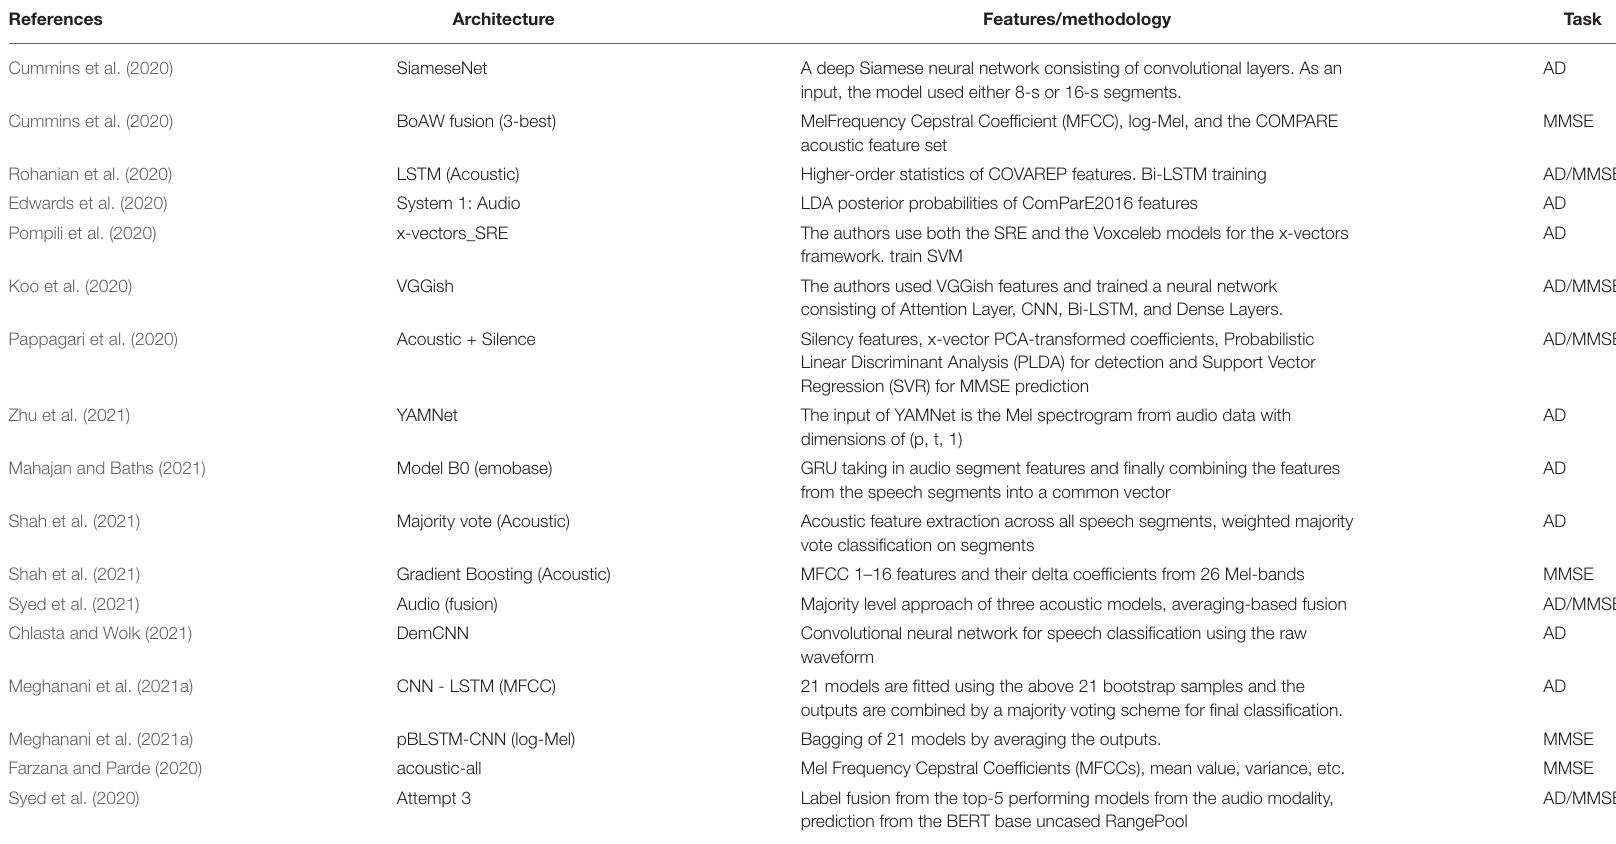
TABLE 3 | Overview of the unimodal state-of-the-art approaches using only speech, which are later compared with our